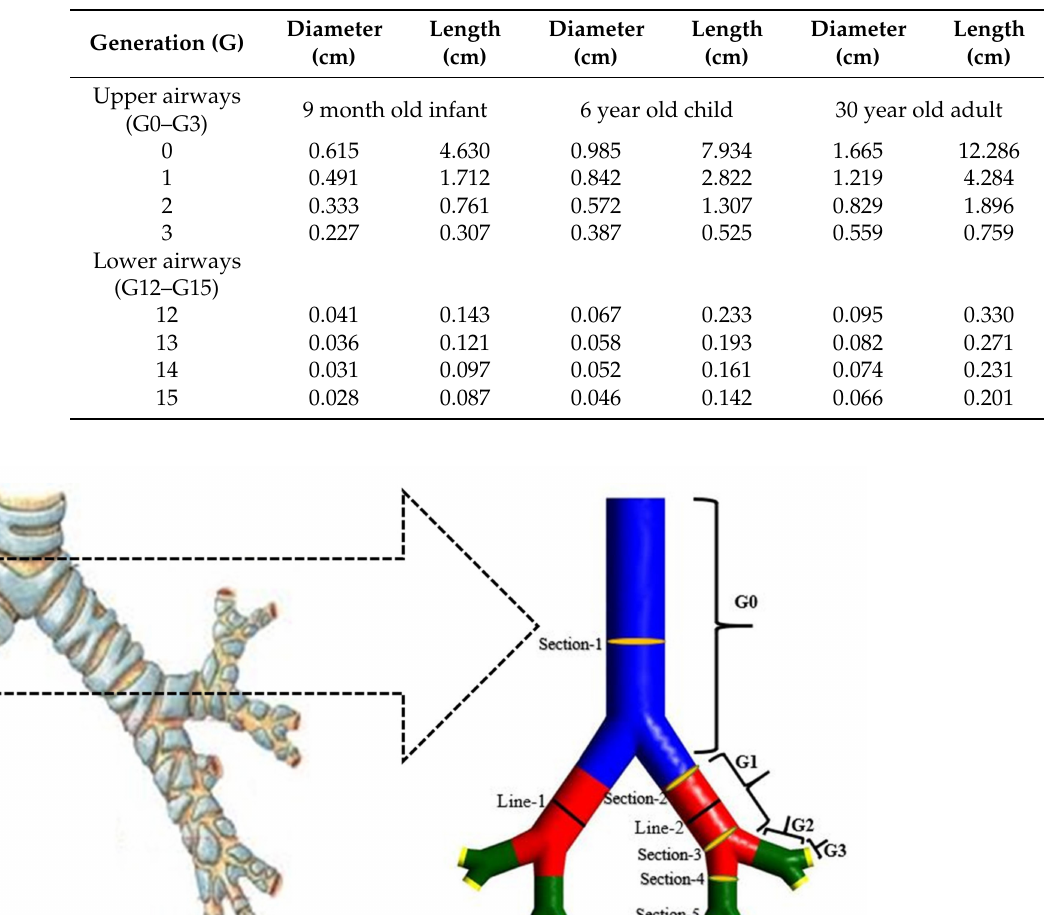
Table 1. The parameters of symmetric lung airways [23].